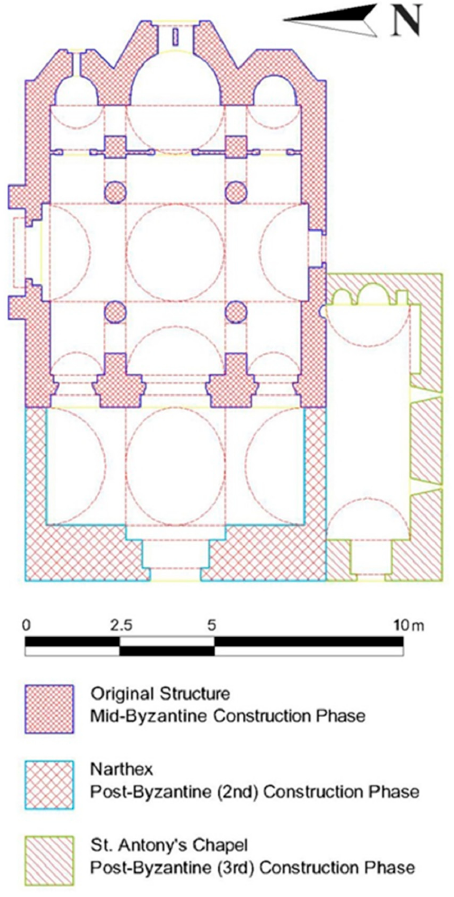
Figure 6. Plan view of the Kaisariani monastery.